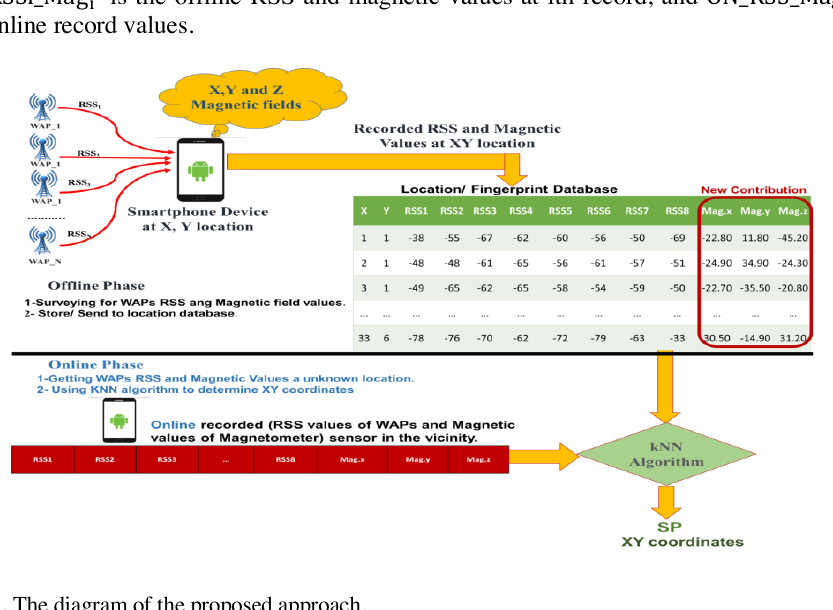
Fig. 1 . The diagram of the proposed